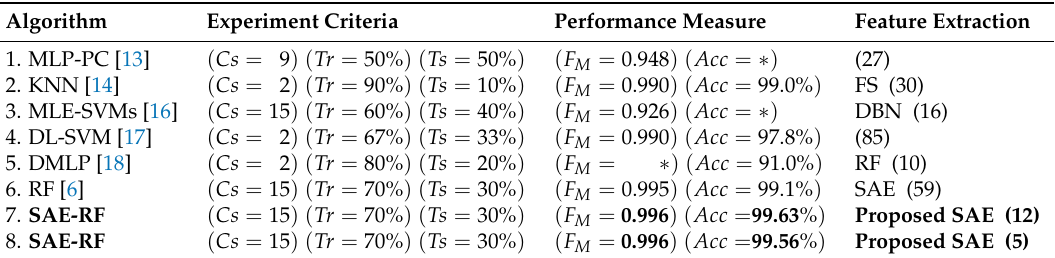
Table 2. Summary of the experimental results and comparison with other